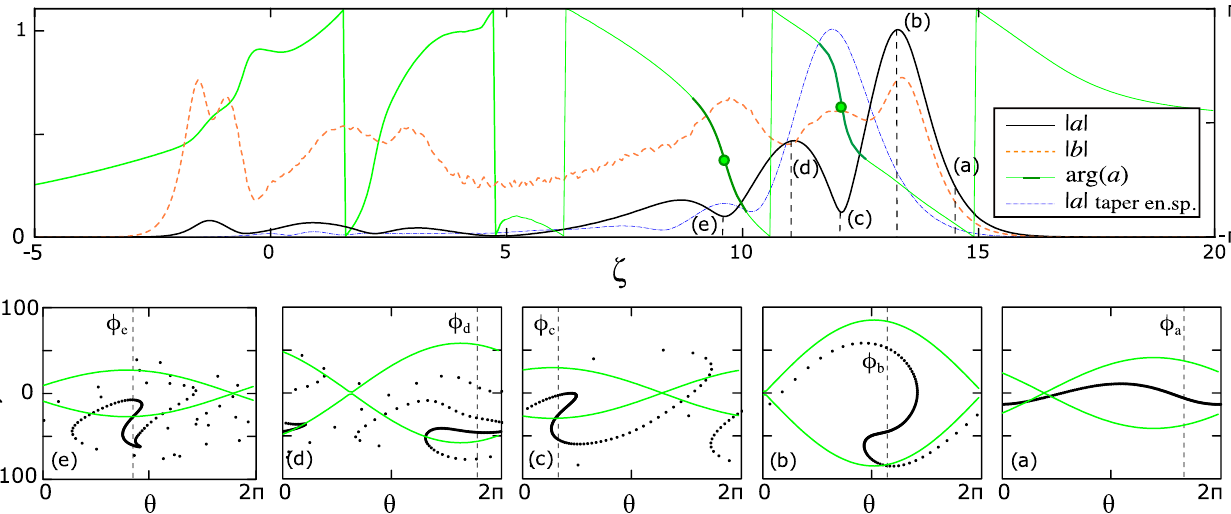
FIG. 4. Field amplitude normalized to the peak (black line), field phase (green-right scale) and modulus of the bunching factor (dashed- orange)vs ζ ,areshown(at u ¼ 15 ).Thefieldphaseatthepositions(c)and(e)correspondingtothefieldamplitudeminimainthefrontmode, isindicatedbythegreendotandthephaselineisinevidenceindarkgreenintheregionsofphaseshiftsbetweenthepeaks.Thee-beamphase spaces at the positions (a – e) are plotted in the bottom row figures. The green lines in (a – e) represent the separatrices S (cid:3) ¼ ffiffiffiffiffiffiffiffiffiffiffiffiffiffiffiffiffiffiffiffiffiffiffiffiffiffiffiffiffiffiffiffiffiffiffiffiffiffiffiffiffiffiffiffiffiffiffiffiffiffiffiffiffiffiffiffiffiffiffiffiffiffiffiffiffiffiffiffiffiffiffi p (cid:3) 2 ½ Re ð a Þ sin ð θ Þ þ Im ð a Þ cos ð θ Þ þ j a j(cid:2) showing the field phase and the fraction of trapped electrons. The phase of the bunching ¼ ð 1 . 65 ; 1 . 15 ; 0 . 33 ; 1 . 78 ; 0 . 85 Þ respectively(verticalblack-dashedlines).Theblue-dashed factor b ateachpositionisindicatedby ϕ a;b;c;d;e line represents the field envelope in presence of tapered energy spread, according to the rule given in Eq. (7), with α